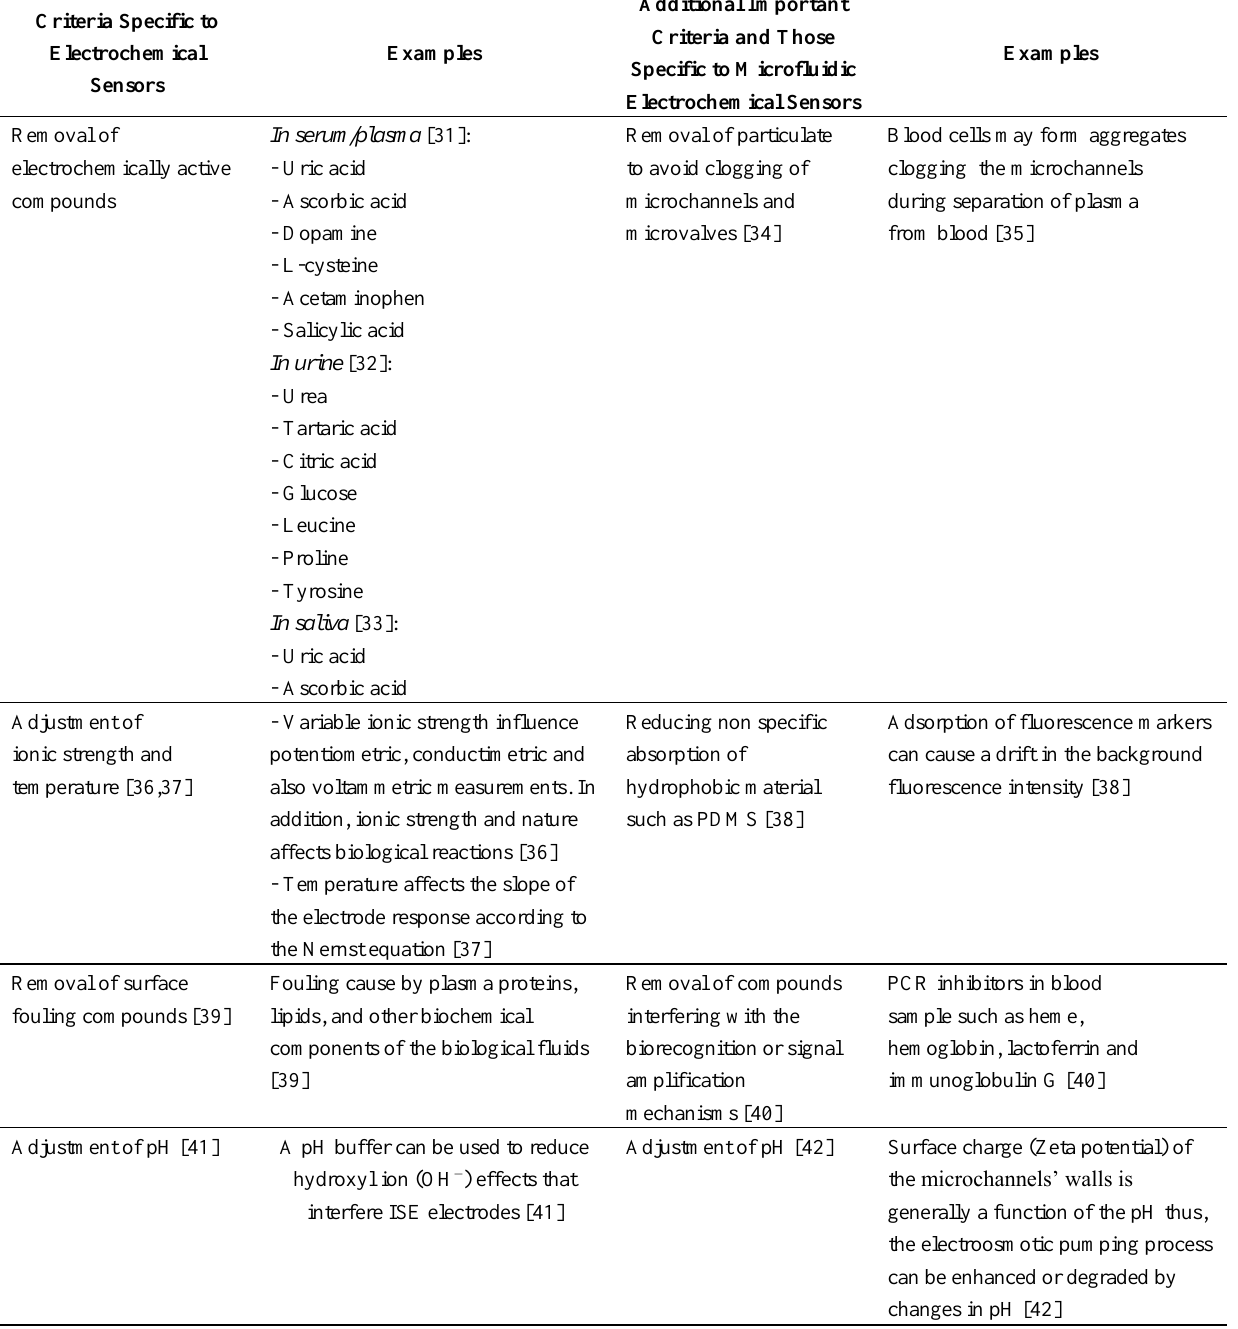
Table 2. Important criteria for sample preparation processes considerations for the development of electrochemical (micro)